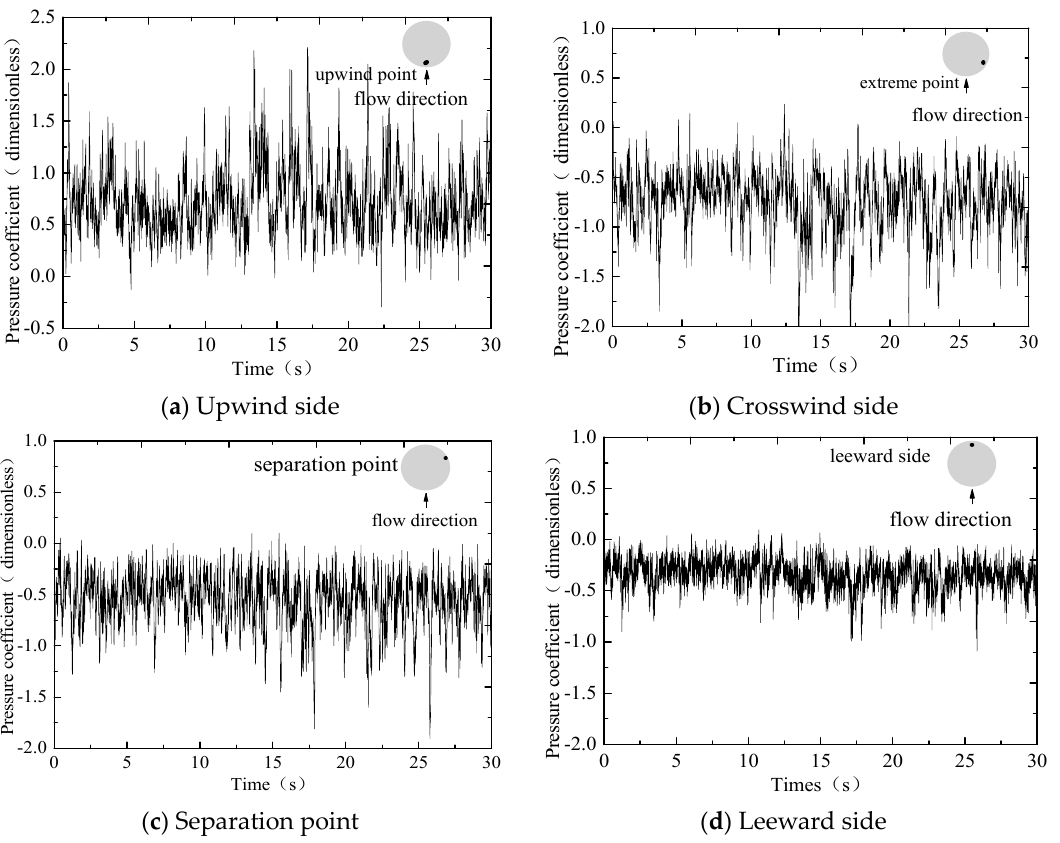
Figure 3. Time history of pressure coefficient at representative measuring points of the built-up tower.